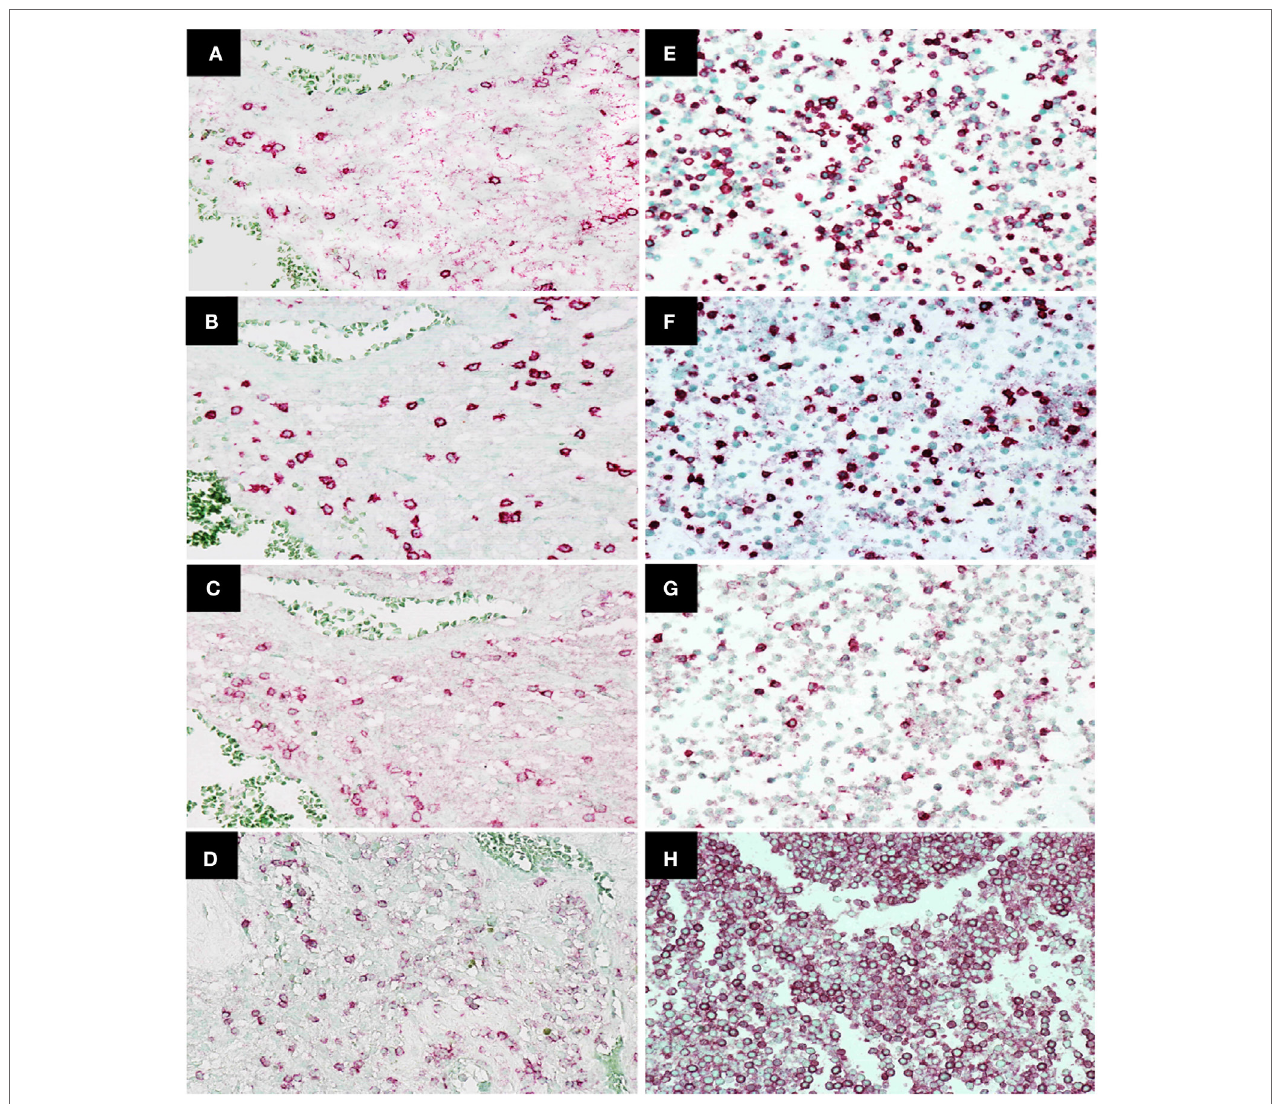
FigUre 2 | Immunohistochemistry staining of CD4, CD8, programed death 1 (PD-1), and CD45 expression in tumor-infiltrating lymphocytes in glioblastoma (GBM) tissue and peripheral blood mononuclear cells. Representative photomicrographs showing staining for CD4 (a) , CD8 (B) , PD-1 (c) , and CD45 (D) in GBM histological tissue sections (400 × magnification) and CD4 (e) , CD8 (F) , PD-1 (g) , and CD45 (h) in peripheral blood mononuclear cell cytoblocks (400 × magnification).